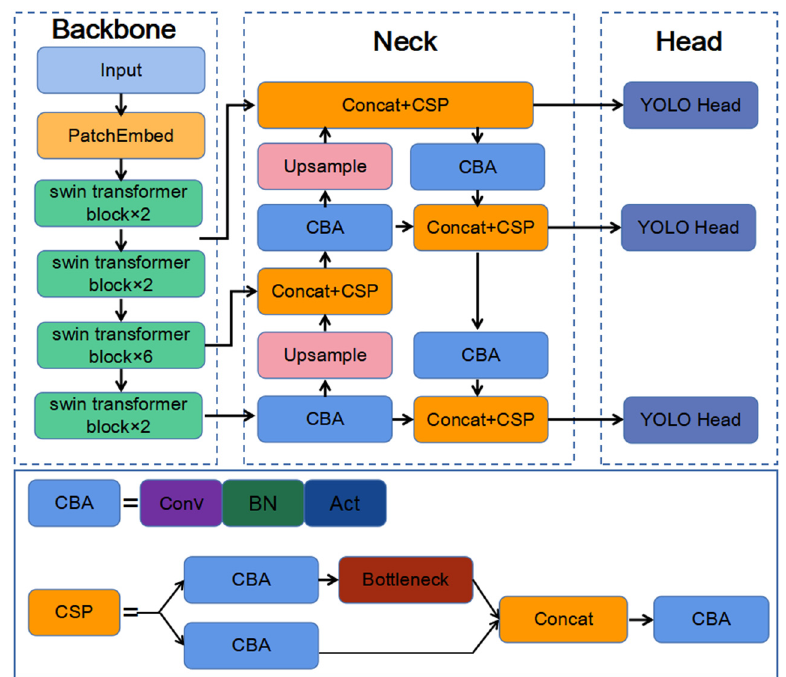
Figure 5. The overall structure of Swin-T YOLOX.